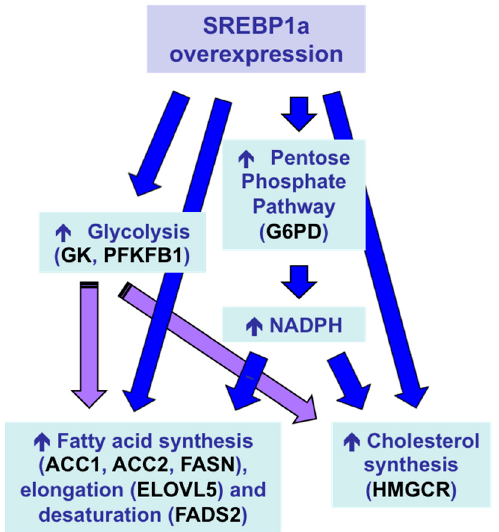
Figure 7. Multigenic action and metabolic effects in the liver of Sparus aurata after intraperitoneal administration of chitosan–TPP–DNA nanoparticles to overexpress exogenous SREBP1a [157]. ACC1, acetyl-CoA carboxylase 1; ACC2, acetyl-CoA carboxylase 2; ELOVL5, elongation of very long chain fatty acids protein 5; FADS2, fatty acid desaturase 2; G6PD, glucose 6-phophate dehydrogenase; GK, glucokinase; HMGCR, 3-hydroxy-3-methylglutaryl-coenzyme A reductase; PFKFB1, 6-phosphofructo 2-kinase/fructose 2,6-bisphosphatase.